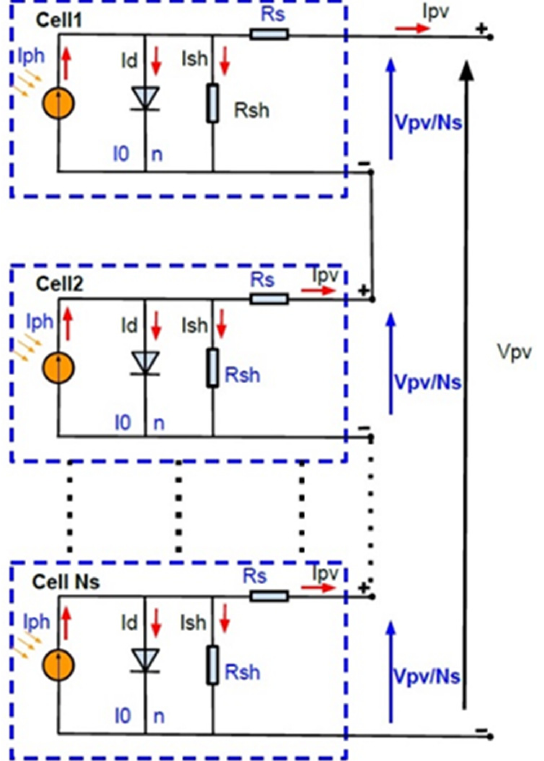
Figure 10. Single-diode model for a PV module with N s cells in series.